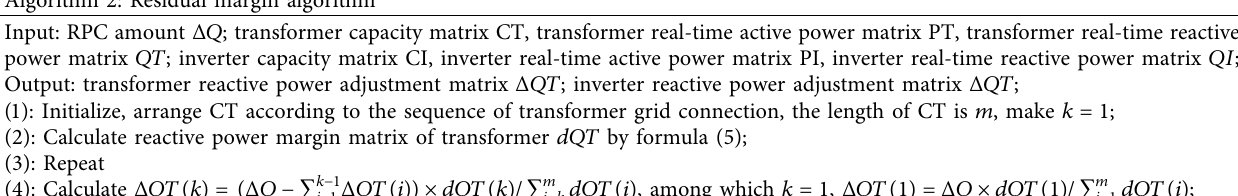
Table 5: Residual margin algorithm of one-dimensional dynamic capacity. Algorithm 2: Residual margin algorithm